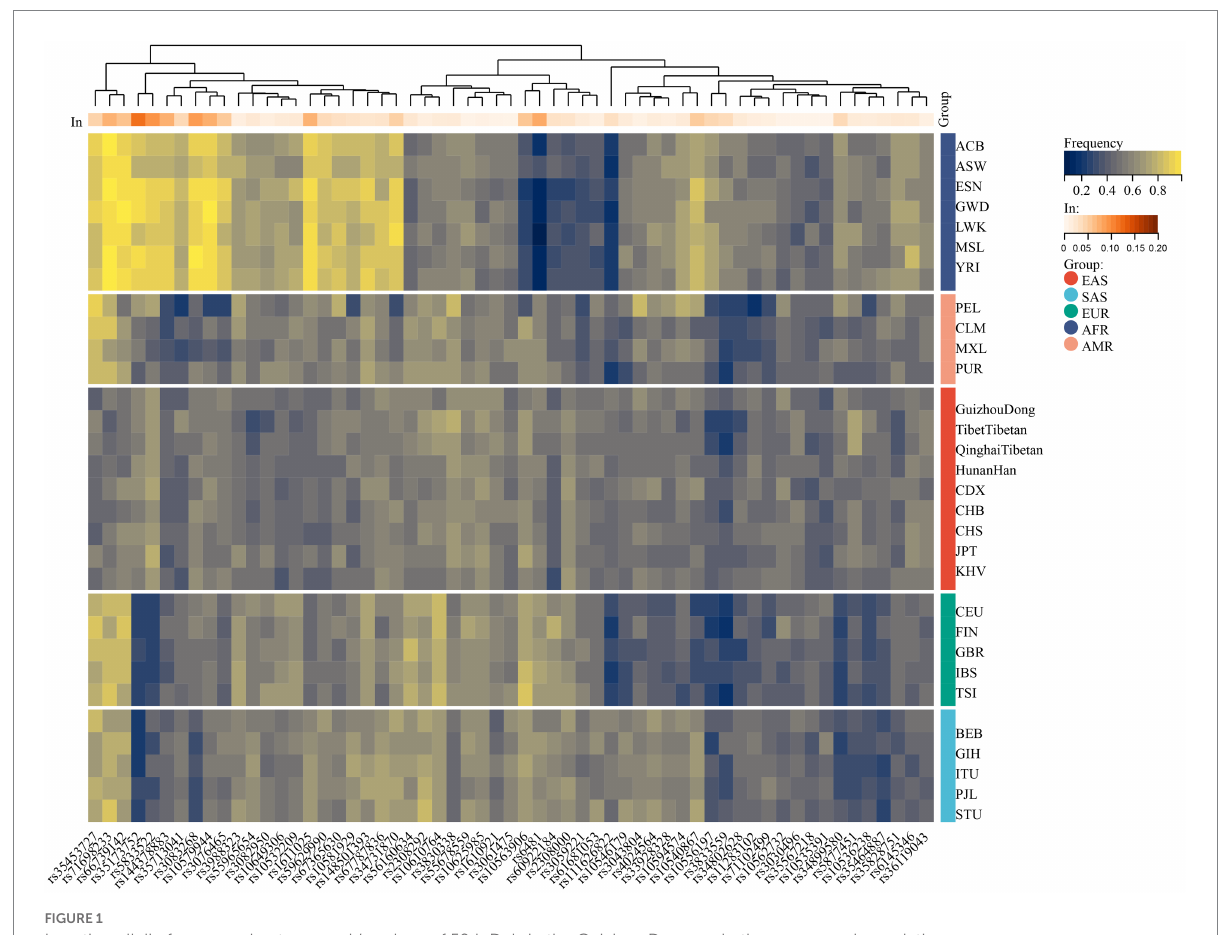
FIGURE 1 Insertion allelic frequency heatmap and In values of 59 InDels in the Guizhou Dong and other compared